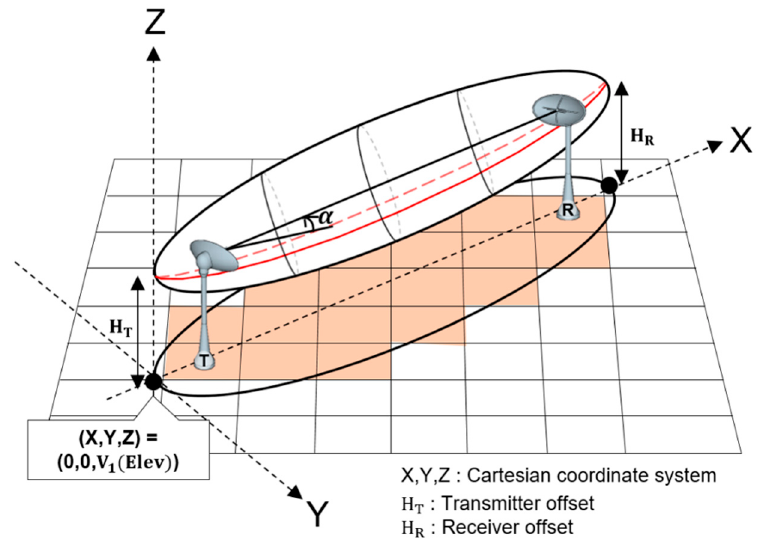
Figure 5. Conceptual view showing the procedure for transforming the coordinate system from the xy coordinate grid to the modified Cartesian coordinate system.